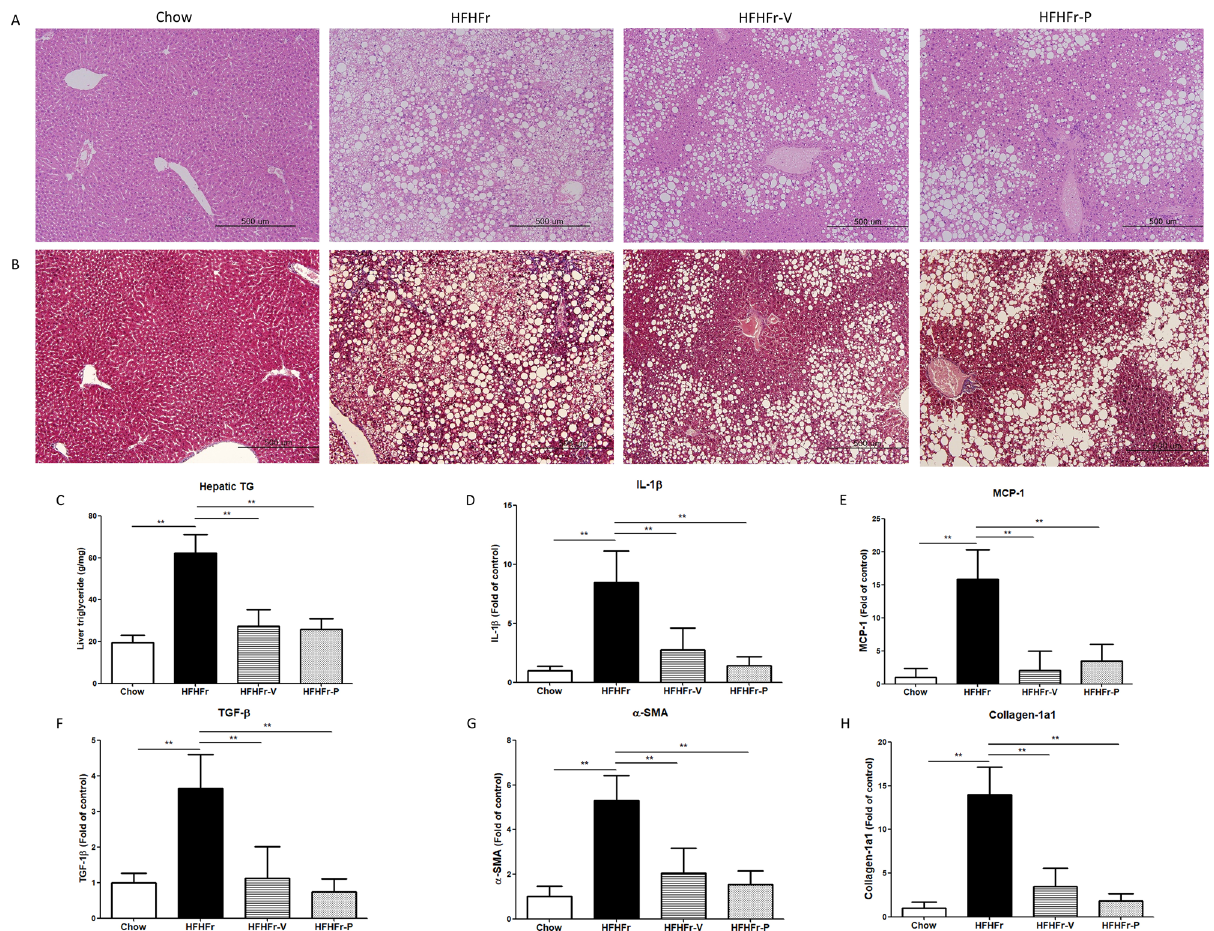
Figure 1. Effects of voglibose on non-alcoholic fatty liver disease. ( A ) Histopathological images of the hematoxylin and eosin stained liver tissue, and ( B ) Masson’s trichrome stained liver tissue. ( C ) Hepatic triglyceride (TG) level, mRNA expression levels of ( D ) interleukin-1β (IL-1β), ( E ) monocyte chemoattractant protein-1 (MCP-1), ( F ) transforming growth factor-β (TGF-β), ( G ) α-smooth muscle actin (α-SMA), and (H) collagen type 1α1 chain (collagen-1α1). * p < 0.05; ** p < 0.01; HFHFr, high-fat, high-fructose diet group; HFHFr-V, HFHFr diet with voglibose group; HFHFr-P, HFHFr diet with pioglitazone